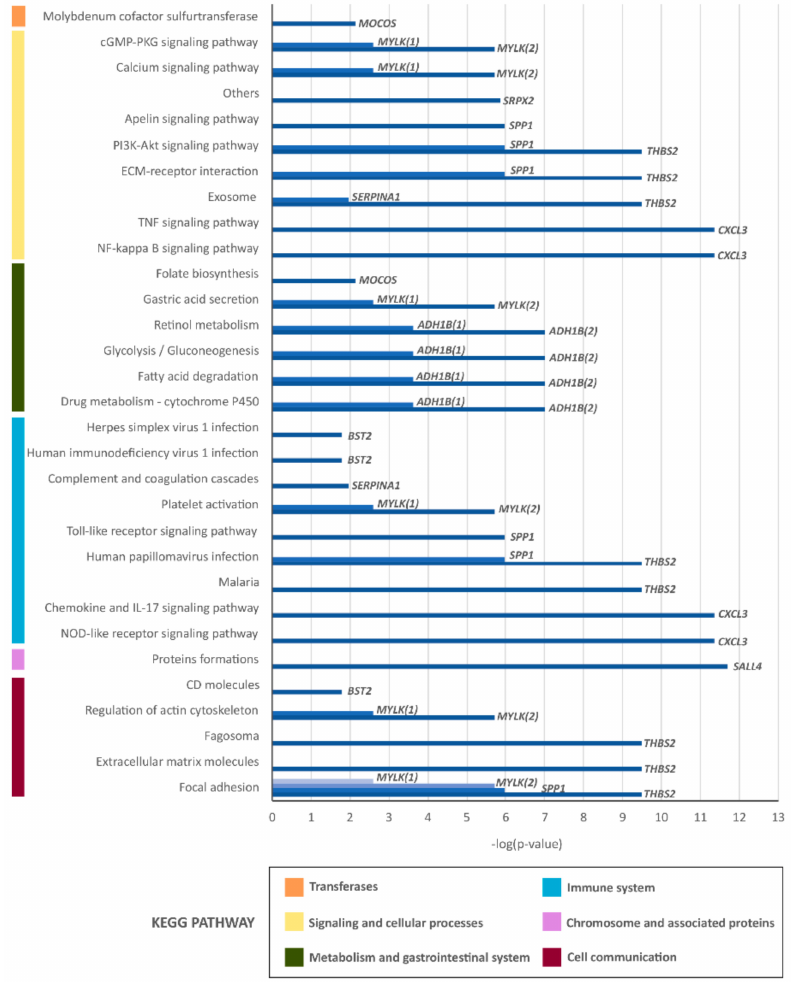
Figure 2. Most representative canonical pathways involved in sCRC tumours as defined by the gene expression profile (GEP) of the most strongly dysregulated